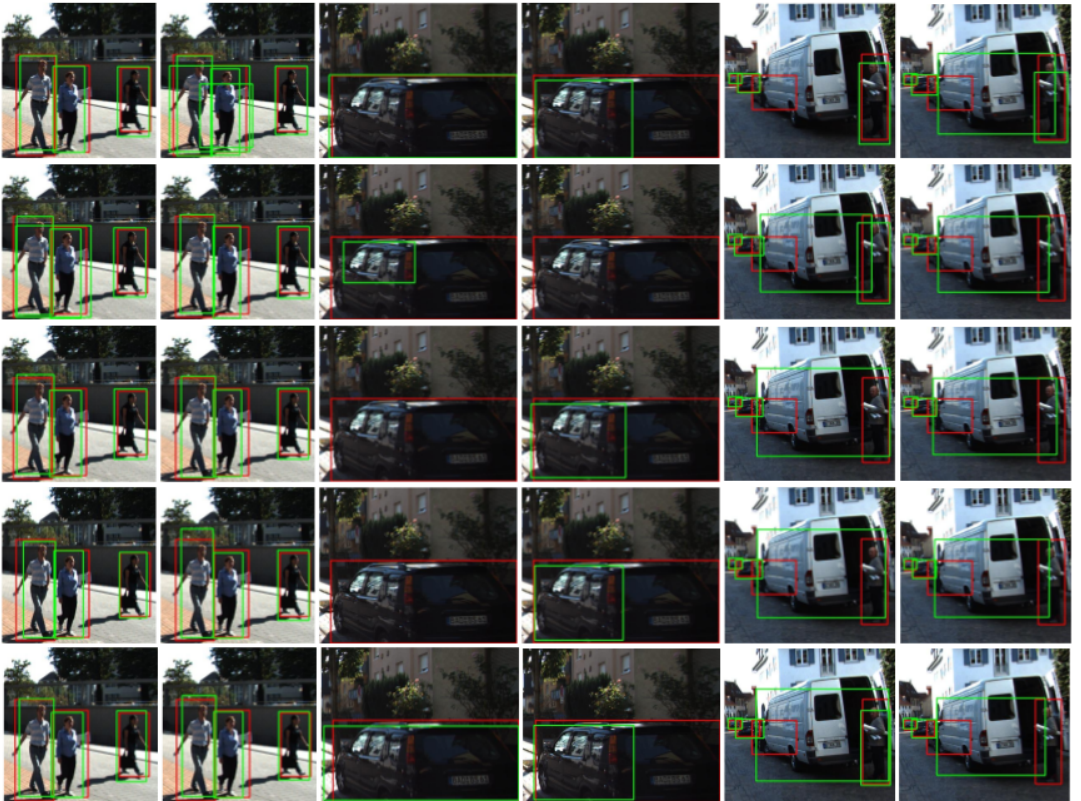
Figure 6. Qualitative results of how φ F would perform on K tt by stopping co-training at different cycles. We focus on co-training and object detection working from V G (ASource). There are three blocks of results vertically arranged. At each K block, the top-left image shows the results when using the 100% human-labeled training data plus V G (Target + ASource), K i.e., UB results. Detection results are shown as green BBs, and GT as red BBs. The top-right image of each block shows the results that we would obtain without leveraging the unlabeled data (ASource), i.e., LB results. The rest of the rows of the block, from top-second to bottom, correspond to stopping co-training at cycles 1, 10, 20, and automatically. In these rows, the images at the left column correspond to multi-modal co-training (i.e., Co-T (RGB/D)) and those at the right column to single-modal co-training (i.e., Co-T